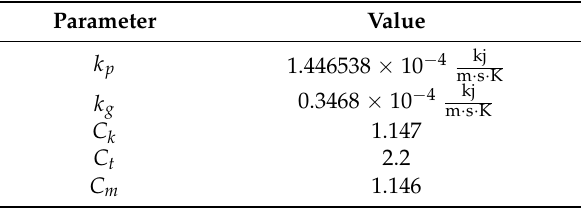
Table 1. Constant parameters used in Equation (7)